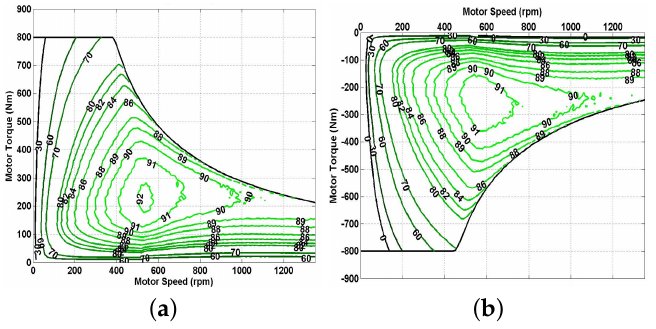
Figure 4. Motor efficiency. ( a ) Motor driving efficiency. ( b ) Motor braking